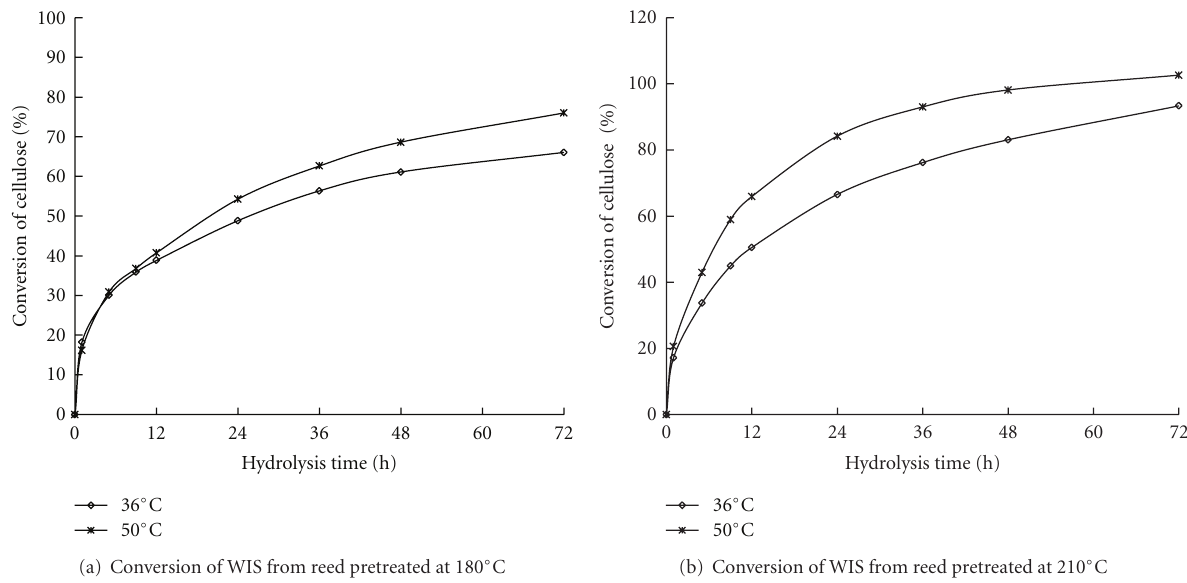
Figure 4: Temperature e ff ects on the WIS conversion from reed in the LHW pretreatment at 180 ◦ C and 210 ◦ C for 20min. ∗ Enzymatic hydrolysis: 30FPU/g oven-dried WIS at